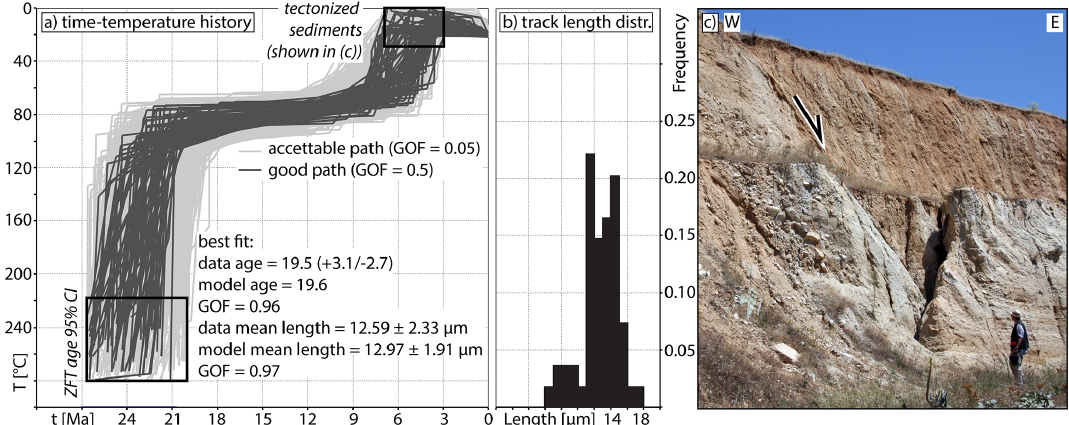
Figure 10. (a) t – T paths of sample 09-055 modeled with computer program HeFTy (Ketcham, 2005). The “acceptable” ( > 0.05) and “good” ( > 0.5) goodness-of-fit indicate non-failure at 95 and 50% confidence interval, respectively. Inverse modeling is based on the simulation of 50000 random t – T paths. (b) Distribution of counted horizontal track lengths. (c) Normal fault in deltaic-lacustrine sediments ( < 5Ma) unconformably covering the Pelagonia crystalline rocks (40 ◦ 19 (cid:48) 49.4 (cid:48)(cid:48) N, 22 ◦ 08 (cid:48) 33.5 (cid:48)(cid:48)